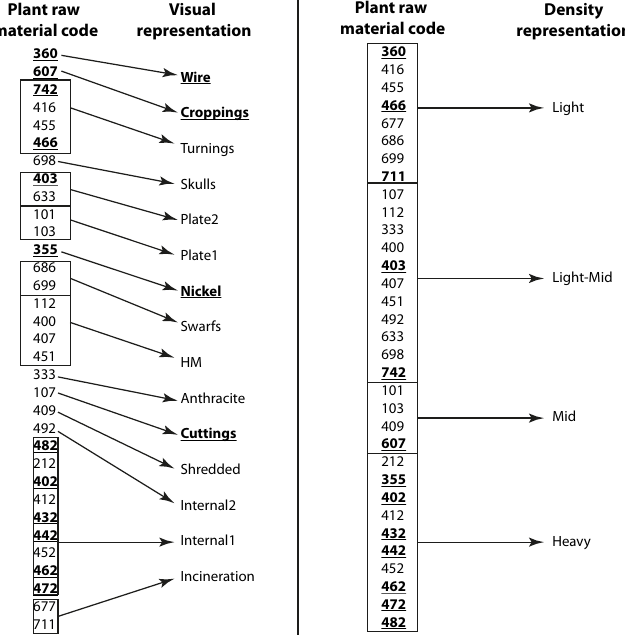
Figure 3. The relationship between the steel plant scrap types and the two scrap representations based on visual and estimated apparent density properties, respectively. The bold underlined scrap types and categories occur in less than 10% of the heats and are therefore bundled together into two aggregate variables, SCR Aggr and Aggregate , for the plant scrap representation and visual scrap representation,